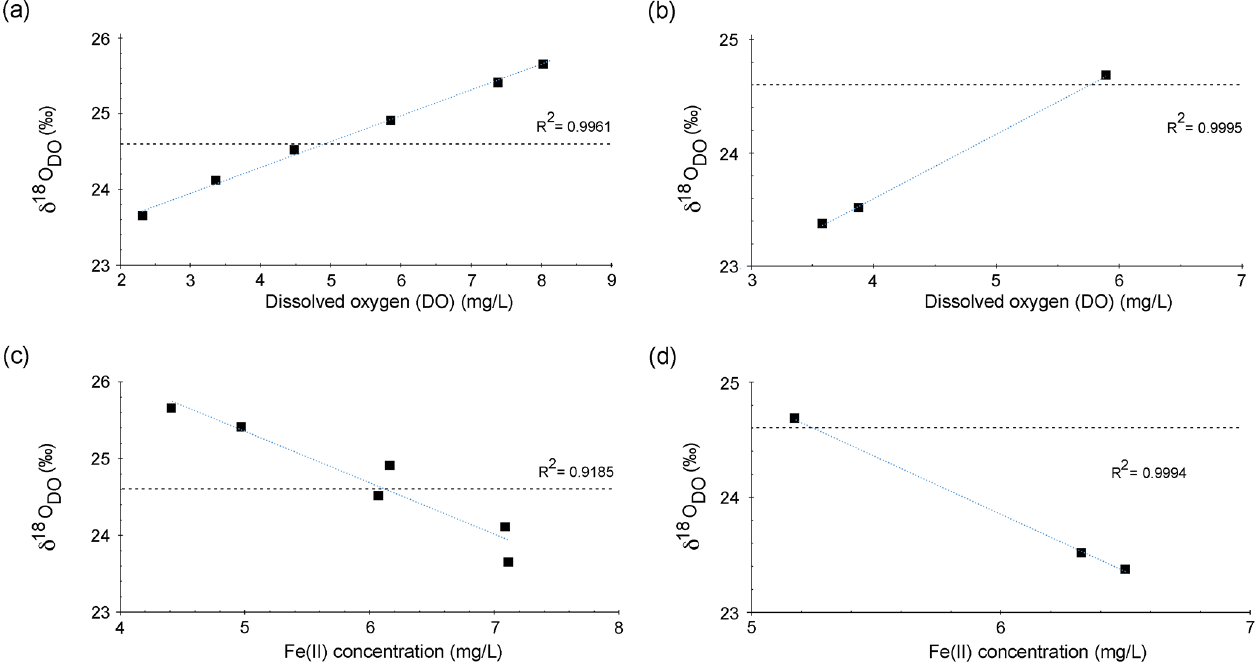
Figure 6. Correlation between δ 18 O DO and DO over the course of the spring for zone 1 in the cold season (a) and the warm season (b) . Correlation between δ 18 O DO and Fe(II) contents over the course of the stream for zone 1 in the cold season (c) and the warm season (d) .